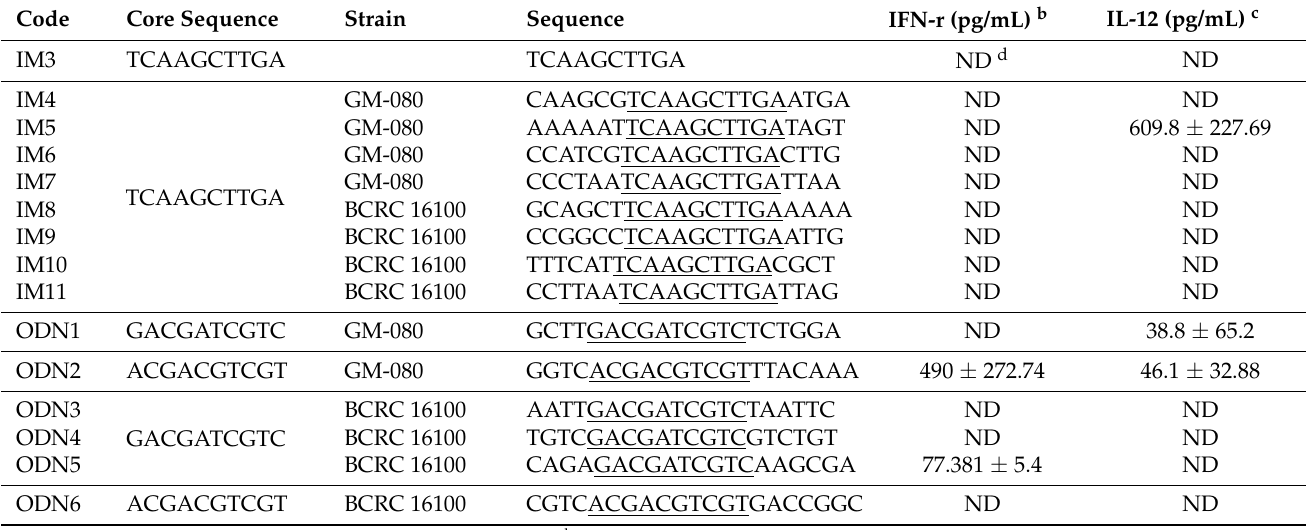
Table 2. Immunoregulatory effects of putative IM and CpG-containing ODN a in GM-080 and BCRC